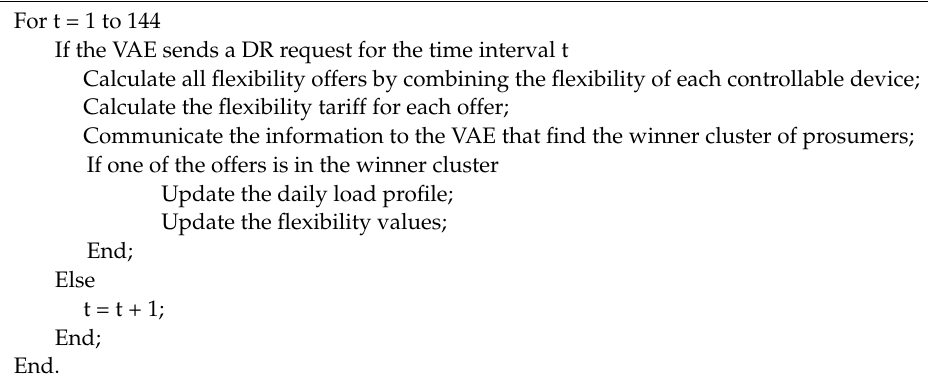
Algorithm 1 Pseudocode of the algorithm of the day-ahead estimation